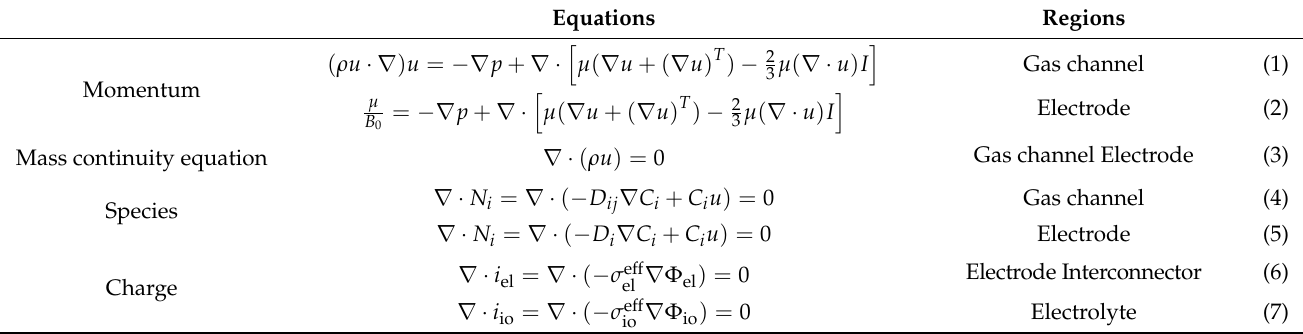
Table 1. Governing Table 1. Governing equations.